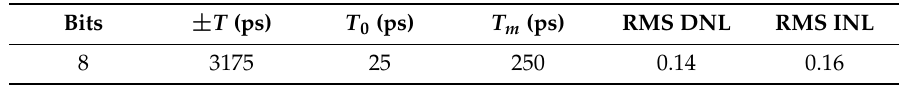
Figure 38. ( a ) INL normalized to LSB ( b ) DNL normalized to LSB for code words at 8-bit SA-TDC with symmetrized multiplexers and T m = 250 ps. Table 3. Parameters of SA-TDC with single set of delay lines and symmetrized multiplexers implemented in 180 nm CMOS technology.